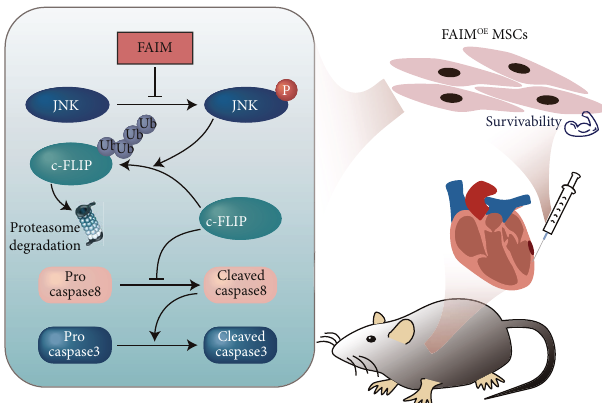
Figure 7: Graphical abstract: Schematic diagram of the proposed mechanism; schematic diagram of the proposed mechanisms by which FAIM impairs the JNK-mediated, ubiquitination – proteasome-dependent degradation of c-FLIP, thereby e ff ectively promoting MSC survival and ultimately ameliorating cardiac function and improving the prognosis of MI in